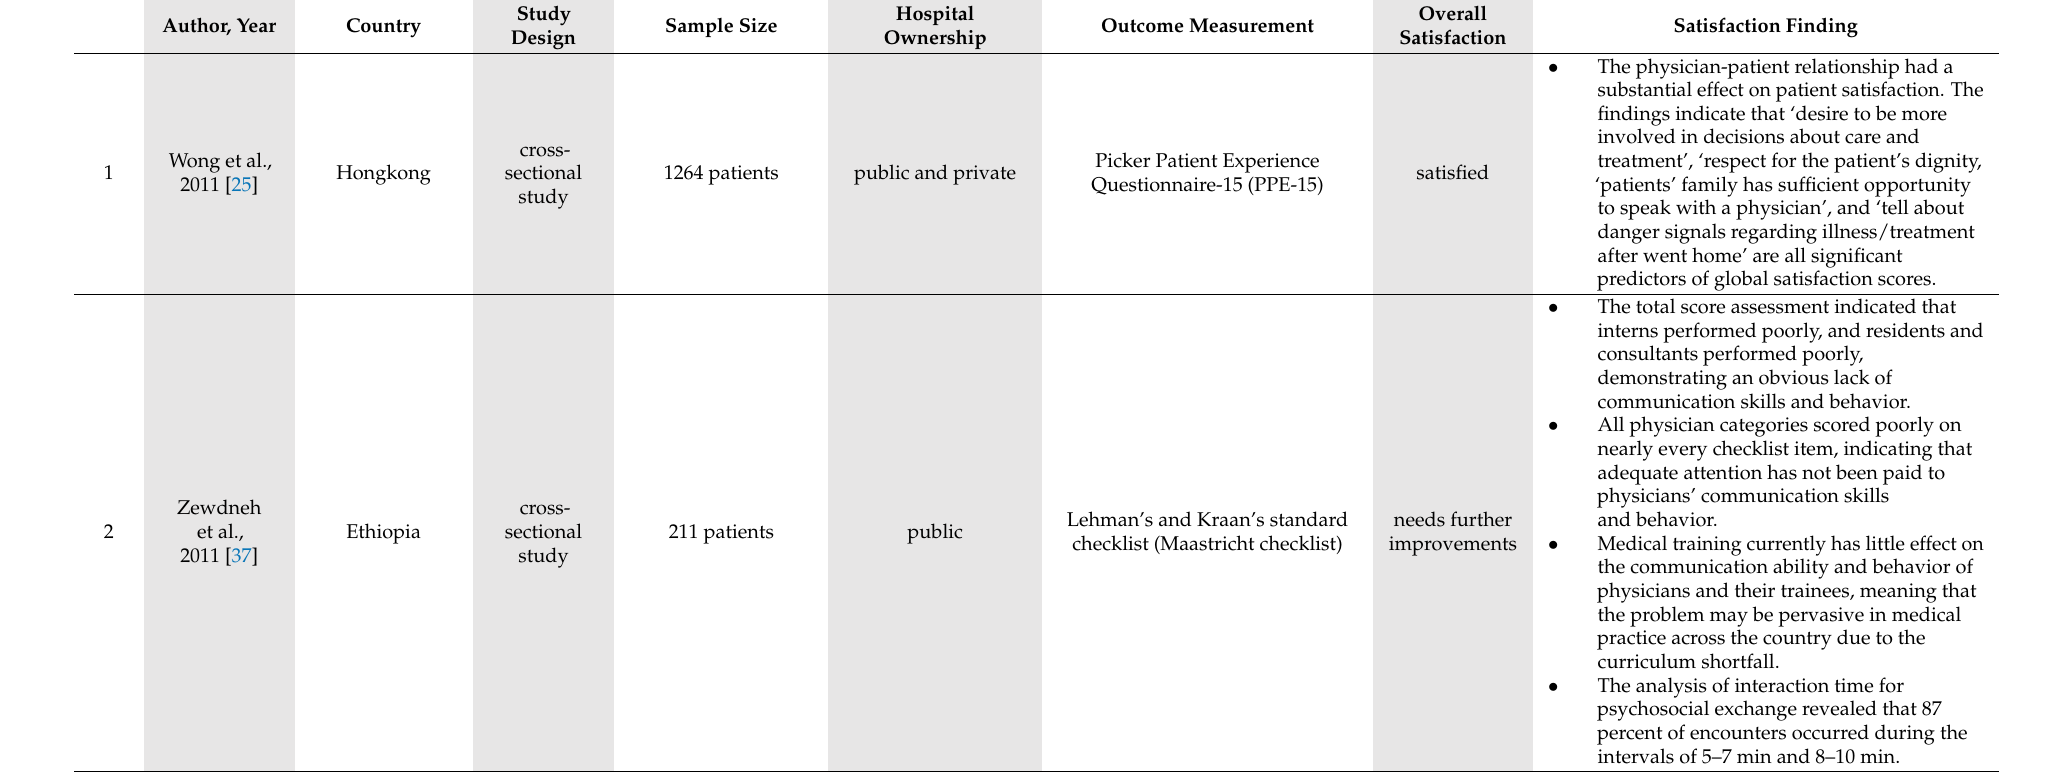
Table 4. Study characteristics of included